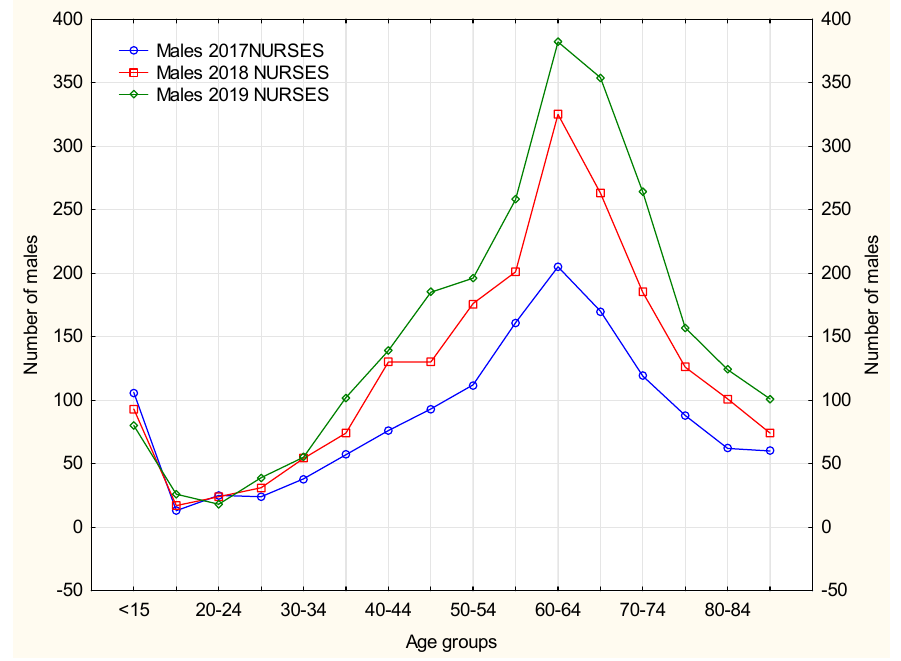
Figure 6. The number of male patients visiting the nurse in each of the analyzed years separately according to age groups.